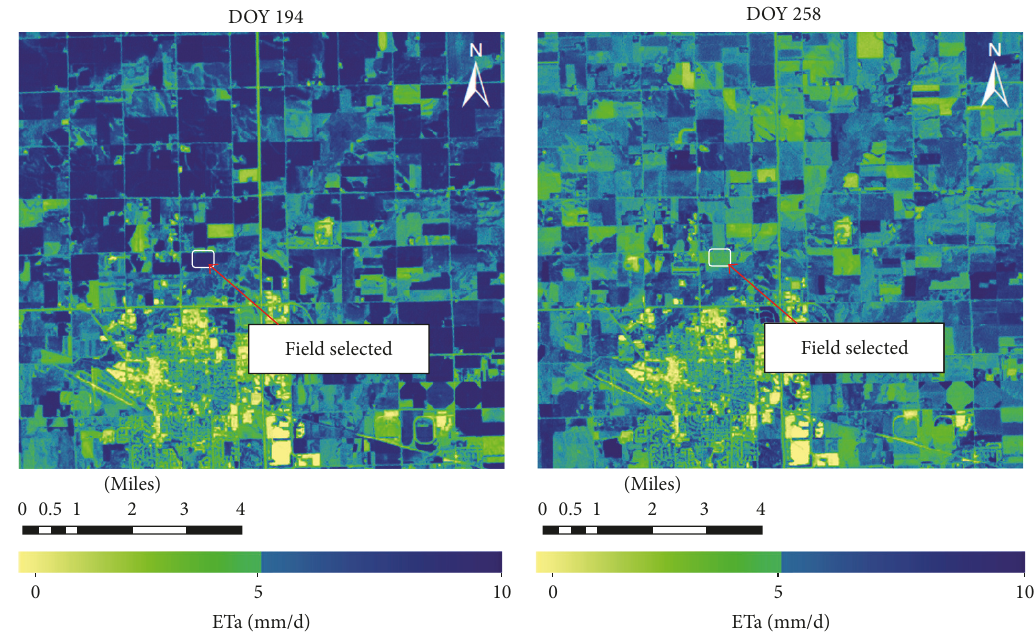
Figure 7: ET maps developed by the METRIC model. White small rectangles show the corn field selected on DOY 194 and DOY 258. These a dates showed high and low ET -METRIC values throughout the 2016 growing season at the Brookings site. a